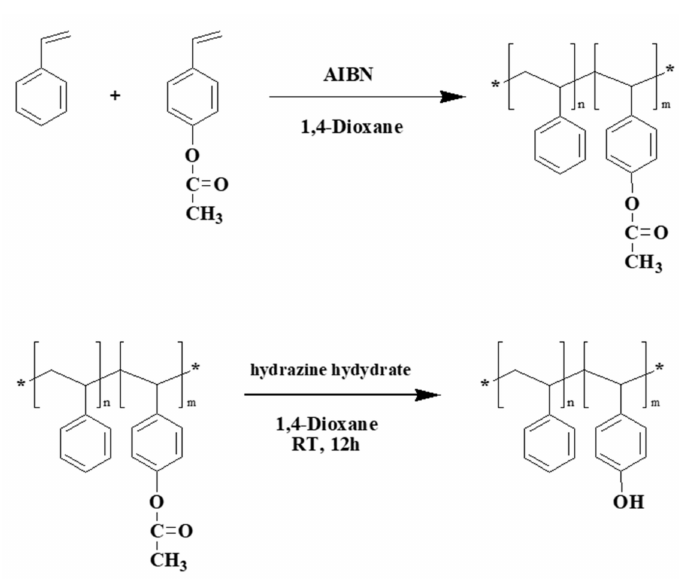
Figure 2. Synthetic routes of PS- co -PHS